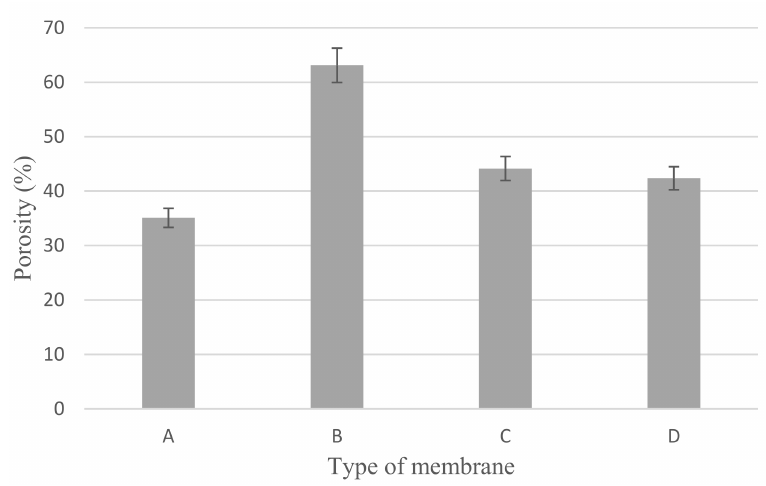
Figure 8. Porosity of (A) neat PVDF membrane, (B) 0.25 Cu 2 O/PVDF DLHF membranes, (C) 0.5 Cu 2 O/PVDF DLHF membranes and (D) 0.75 Cu 2 O/PVDF DLHF membranes with outer dope flowrate 6 mL/min.